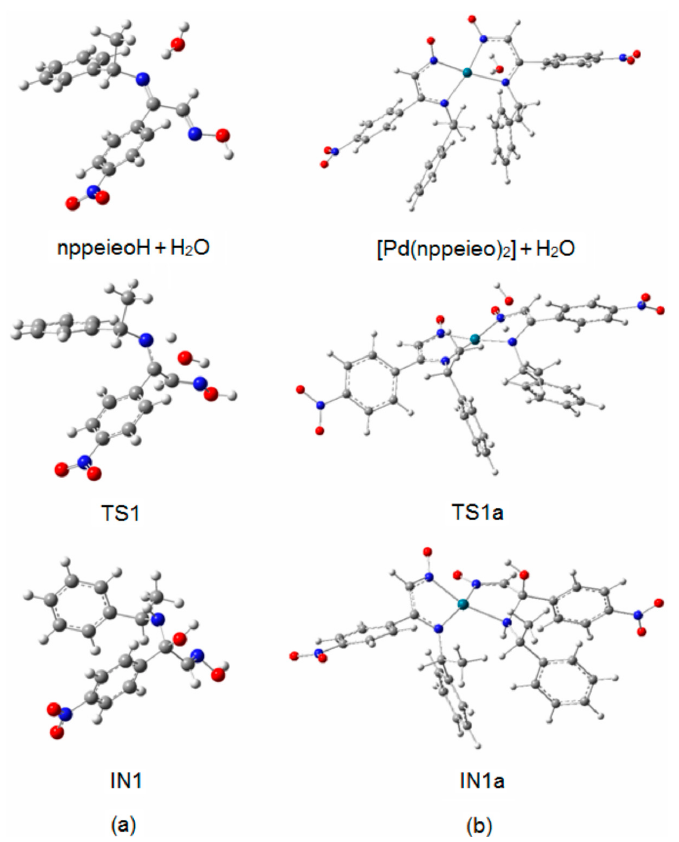
Figure 2. Optimized structures of imine oxime + H 2 O, TS1 and IN1: ( a ) nppeieoH; ( b ) [Pd(nppeieo) 2 ].